Question: In one sentence, what is this figure communicating?
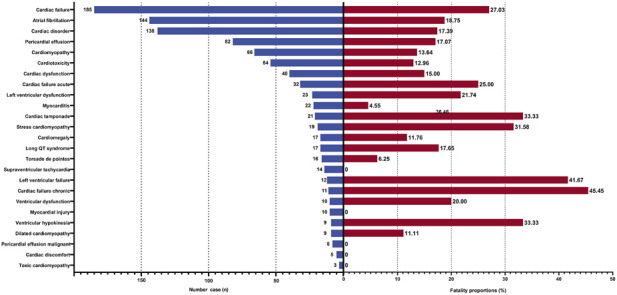
Answer: Report numbers and mortality proportion of different CAEs (PT level) associated with Osimertinib in FAERS.